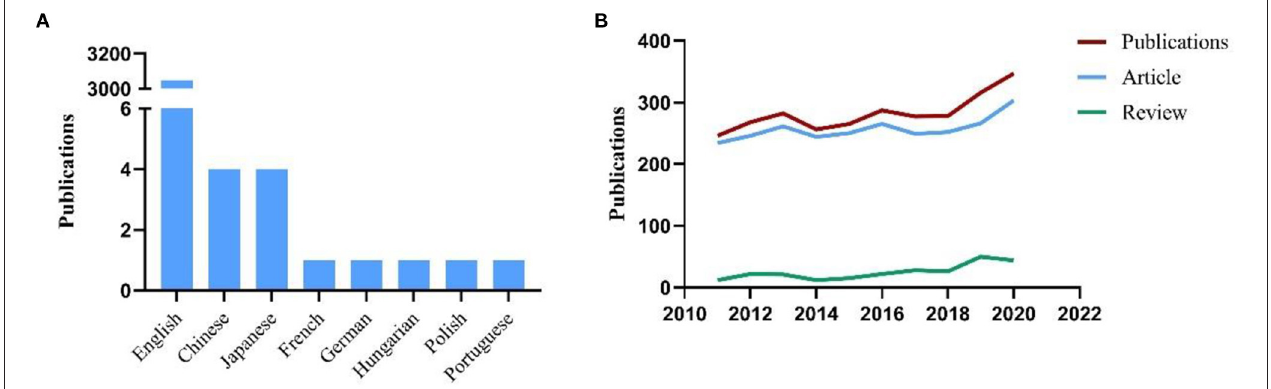
FIGURE 2 | (A) The top 20 most productive countries for CTSB research; (B) Network map showing distribution of collaboration between Countries/Regions; (C) Correlation between total articles published and GDP of 15 highest-output countries.